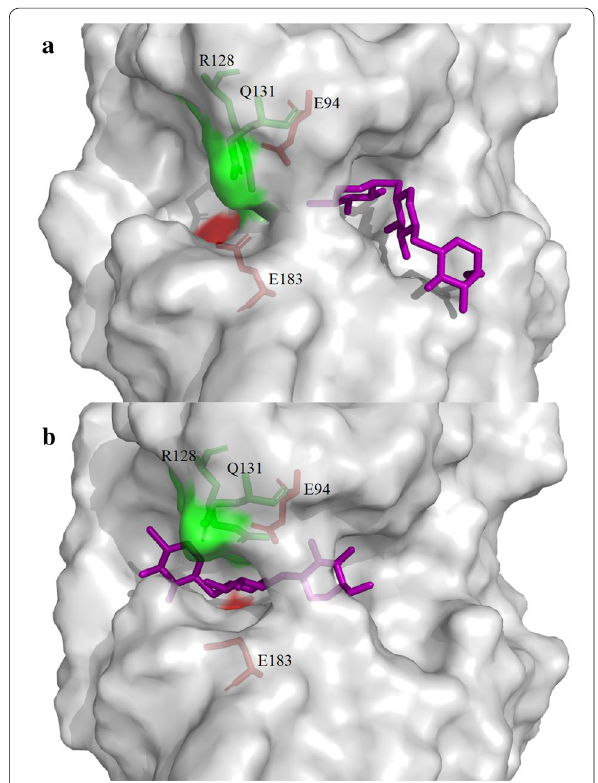
Fig. 6 Docking analysis of XynHBN188A ( a ) and XynHBN188A217 ( b ). The ligand was shown in purple, the two active site residues (E94 and E183) were drawn in red, R128 and Q131 were shown in